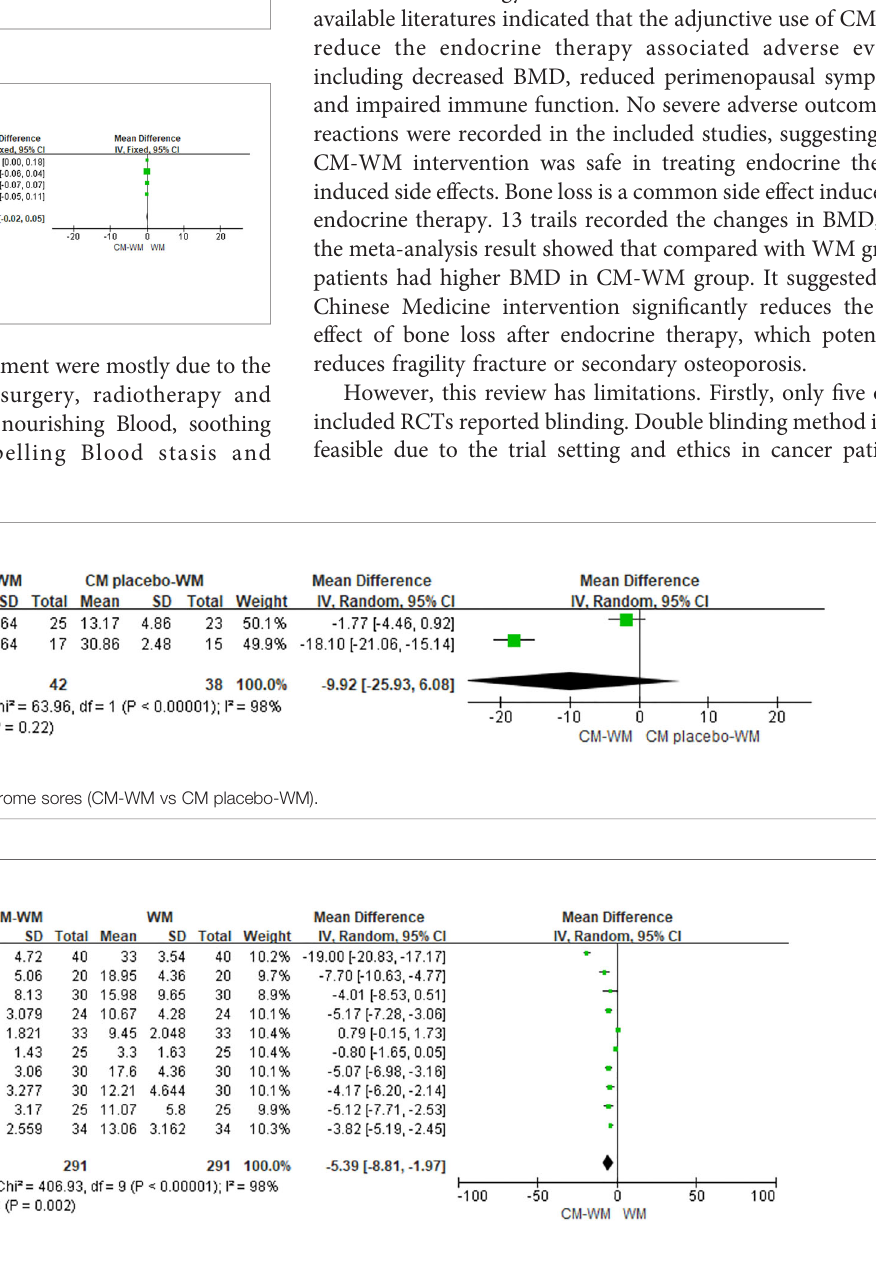
FIGURE 14 | Meta-analyses on TCM syndrome scores (CM-WM vs WM